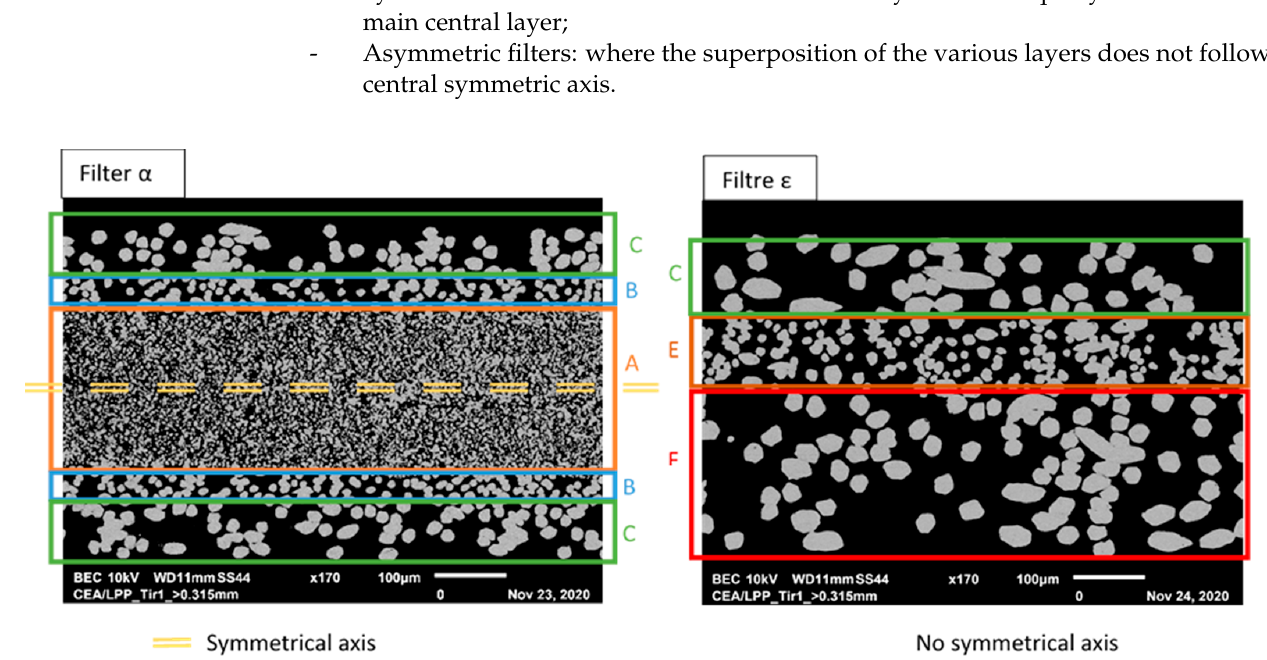
Figure 4. Cross-section of a slice of a symmetrical and an asymmetrical filter (by scanning electron microscope) (A, B, C, E and F correspond to the different monolayers of the multilayer media).